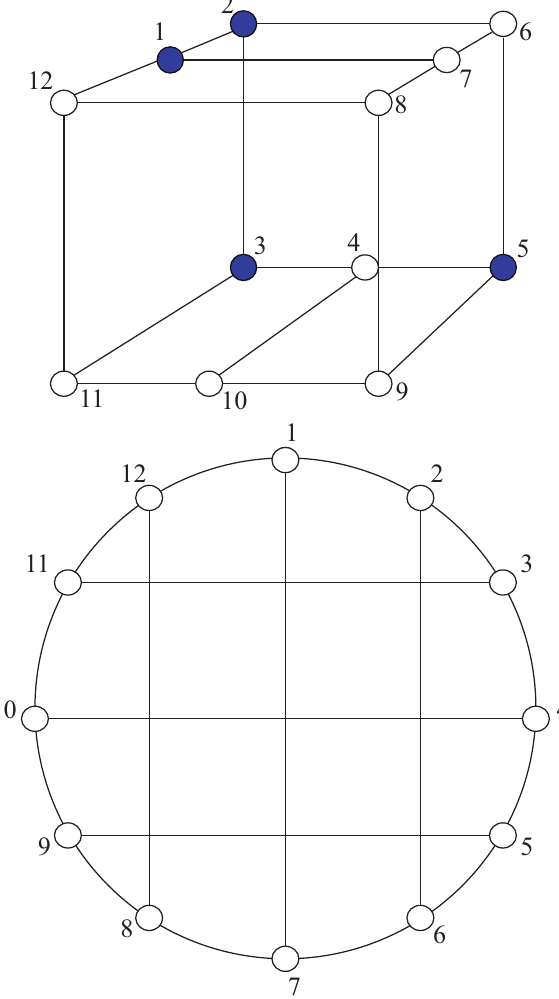
Figure 8: A zero forcing set on the Bidiakis Cube and an alternate